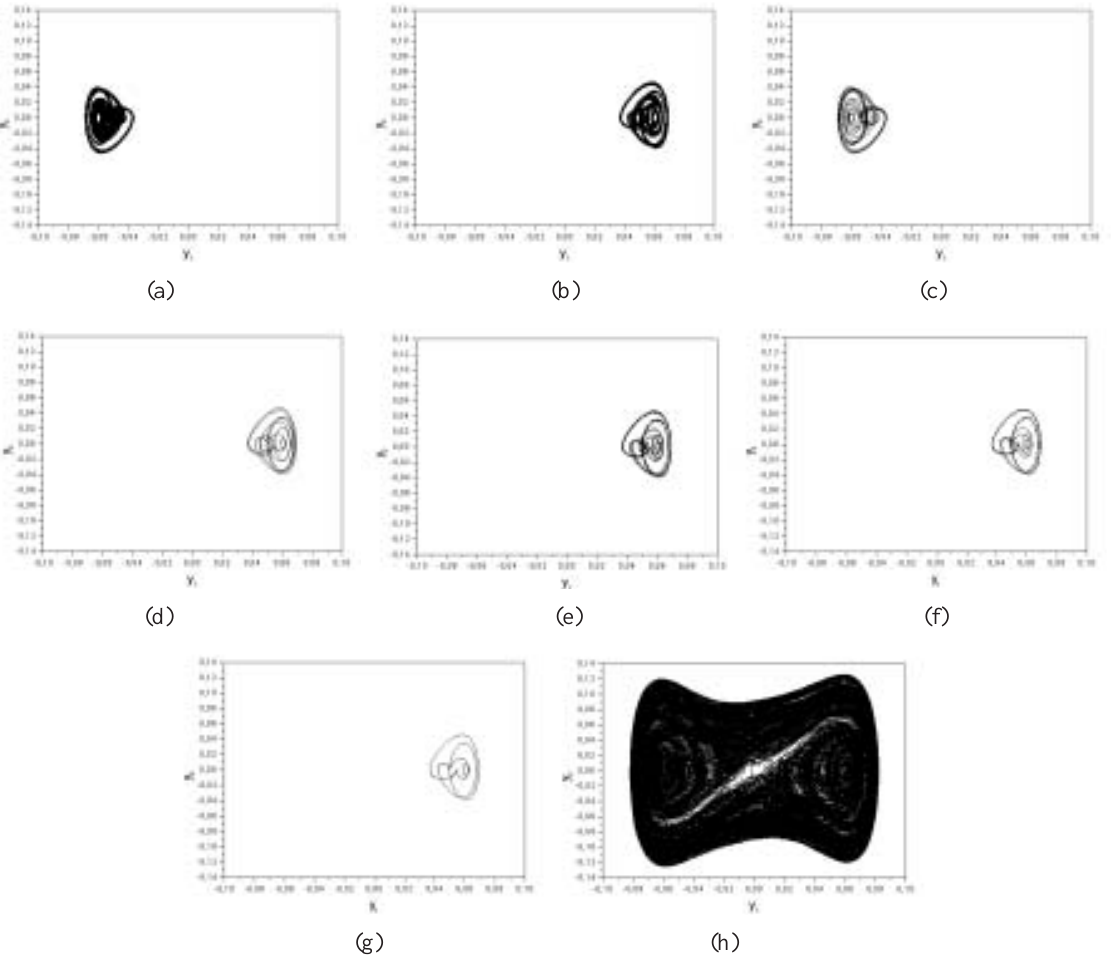
Fig. 16. Evolution of Poincar´e maps due to variation of the temperature parameter θ (formation of a periodic window). (a) θ = 0 . 386 , chaos; (b) θ = 0 . 387 , chaos; (c) θ = 0 . 3875 , period-8; (d) θ = 0 . 389 , period-4; (e) θ = 0 . 38975 , period-8; (f) θ = 0 . 4 , period-4; (g) θ = 0 . 408 , period-2; (h) θ = 0 . 409 ,